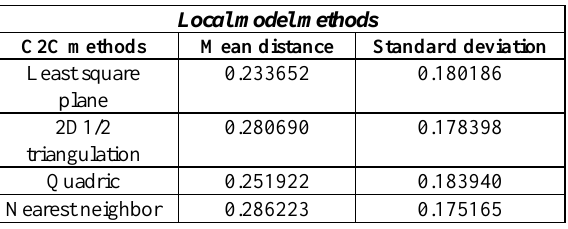
Table 7. Mean distance and standard deviation values for